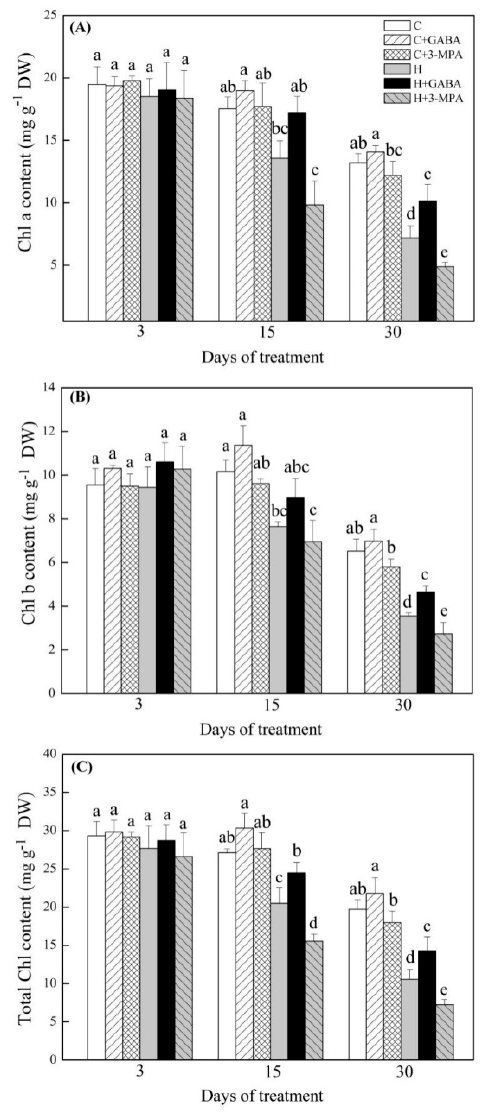
Figure 3. Effects of γ -aminobutyric acid (GABA) and 3-mercaptopropionic acid (3-MPA) on ( A ) chlorophyll (Chl) a content, ( B ) Chl b content, and ( C ) total Chl content in leaf of creeping bentgrass during 30 days of 23/18 (normal condition) or 38/33 °C (heat stress). Vertical bars above columns indicate ±standard error (SE) of means ( n = 4) and different letters above columns indicate significant differences ( p ≤ 0.05). C: control; C+GABA: control + GABA; C+3-MPA: control+3-MPA; H: heat; H+GABA: heat+GABA; H+3-MPA: heat+3-MPA.